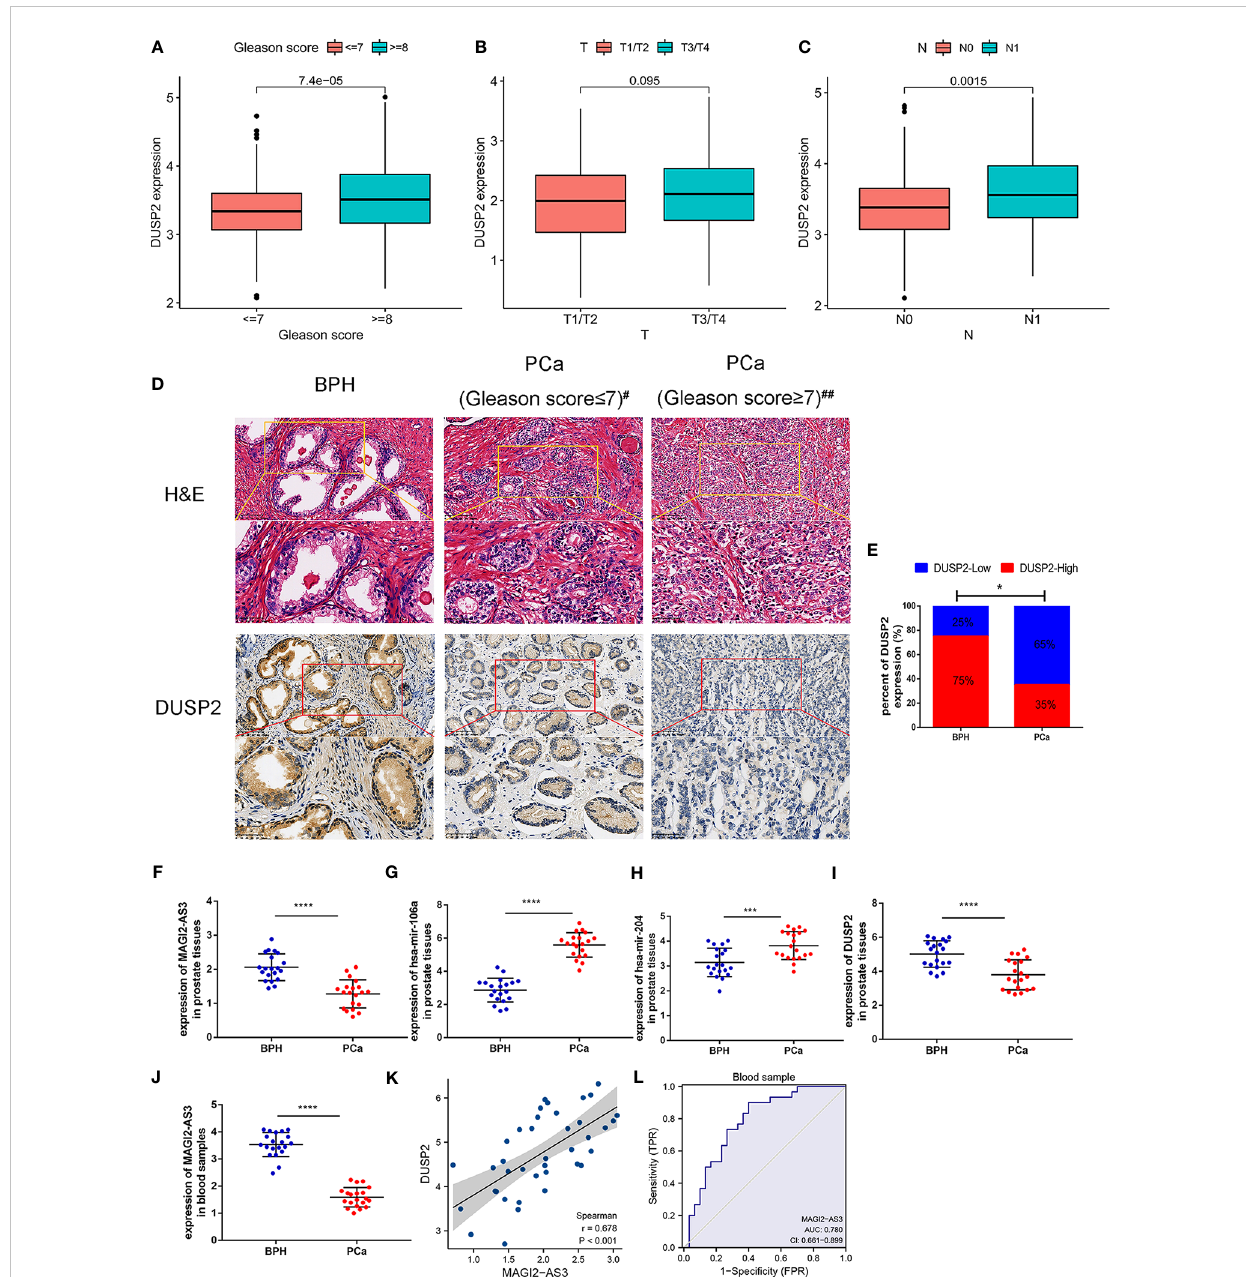
FIGURE 8 Validation of the lncRNA – miRNA – mRNA network in tissue and blood sample. (A – E) The correlation between DUSP2 expression and the clinical characteristics of PCa. (F) Representative hematoxylin and eosin (H&E) staining and immunohistochemical (IHC) staining in 20 PCa tissue samples and 20 BPH tissue samples; # Gleason score = 7(3 + 4), ## Gleason score = 7(4 + 3). (G) The percentage of DUSP2 staining intensity in 20 PCa patients and 20 BPH patients. (H – K) The network molecular expression level in fresh BPH and PCa tissues. (L) Positive correlation between MAGI2- AS3 and DUSP2 in prostate tissues; r = 0.362. (M) The expression of MAGI2-AS3 in the blood of patients with PCa and BPH. (N) ROC curves were plotted to evaluate the predictive accuracy of MAGI2-AS3 expression for PCa diagnosis; AUC = 0.780. * p < 0.05, *** p < 0.001, **** p <